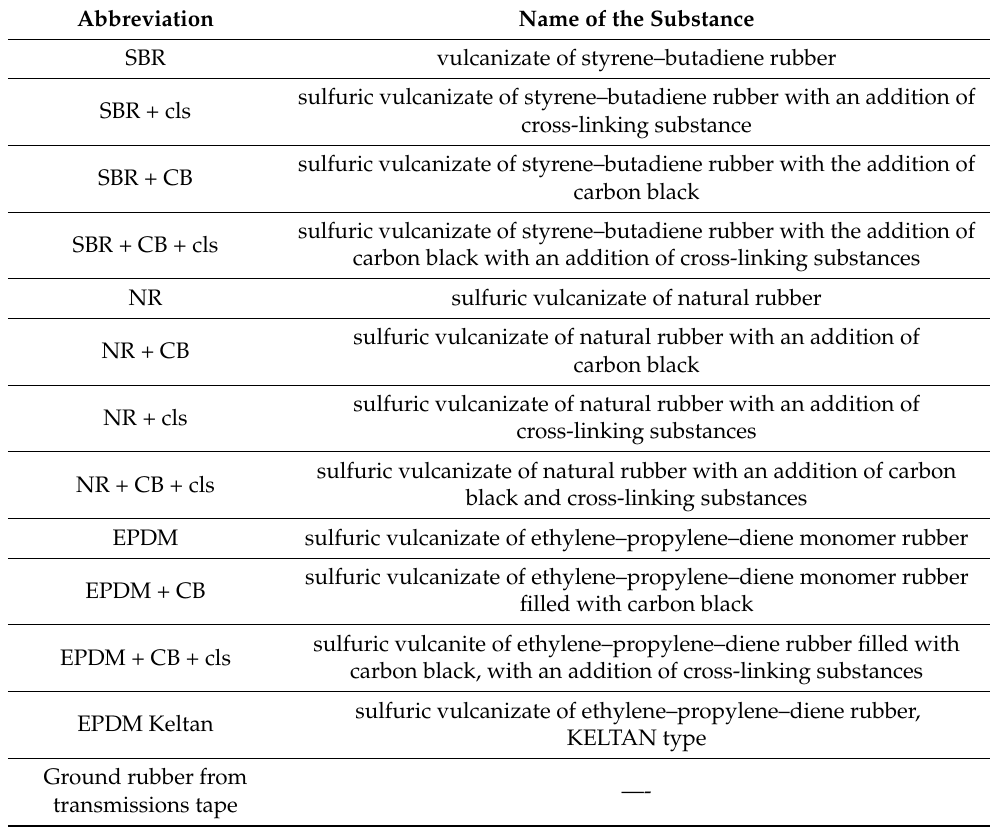
Table 1. Full names of the mixtures used in experiments as a culture medium and their